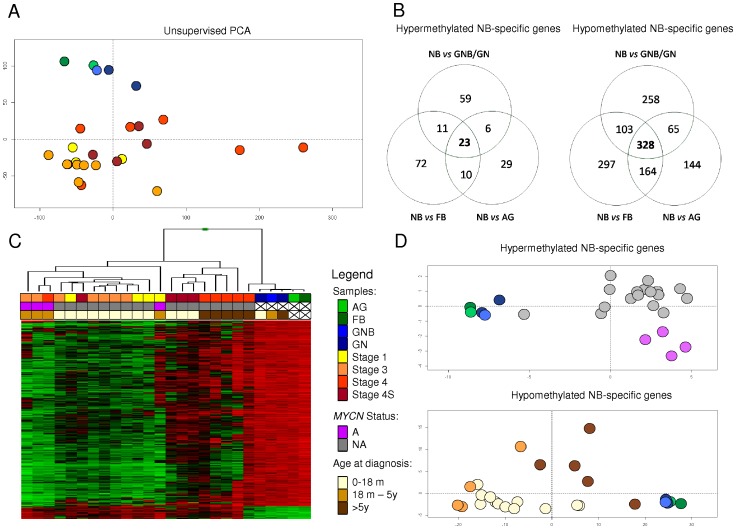
DNA methylation profiling and identification of differentially methylated genes in NB.
A: Unsupervised Principal Component Analysis (PCA) of array-based DNA methylation data in 21 neuroblastomas (NB) (classified according to INSS Stage), 2 ganglioneuroma (GN), 1 ganglioneuroblastoma (GNB); and normal reference samples: fetal brain (FB) and adrenal gland (AG). B: Venn diagram showing the strategy used to identify NB-Specific genes. Hypermethylated and hypomethylated genes in NB were determined using three different supervised analyses with distinct reference samples (FB, AG and GN/GNB). C: Supervised hierarchical cluster analysis of DNA methylation data from NB-specific genes in 21 NB samples, 2 GN, 1 GNB; and 2 normal reference samples: FB and AG. D: Supervised Principal Component Analysis (PCA) in 21 NB samples, 2 GN, 1 GNB; and normal reference samples: FB and AG for NB-specific genes.